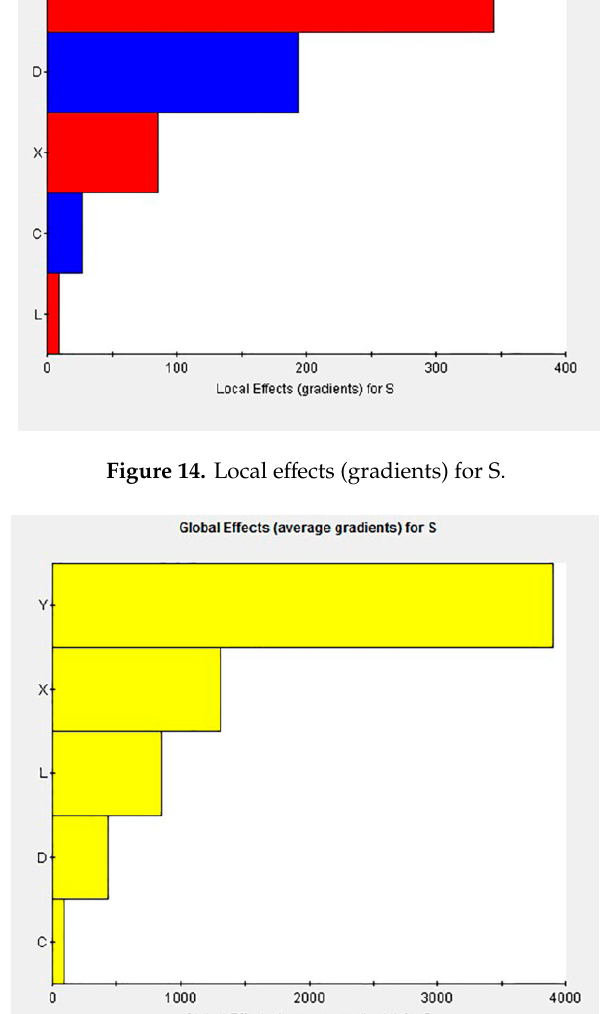
Figure 15. Global effects (average gradients) for S.